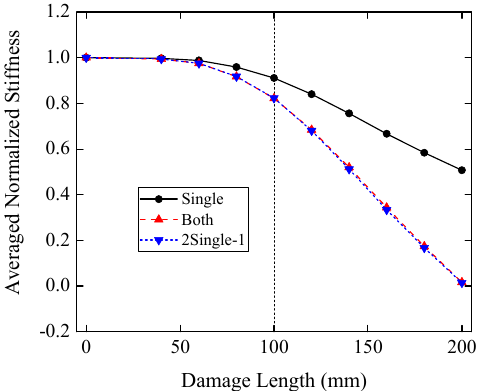
Figure 29. Averaged normalized stiffness of damaged models.